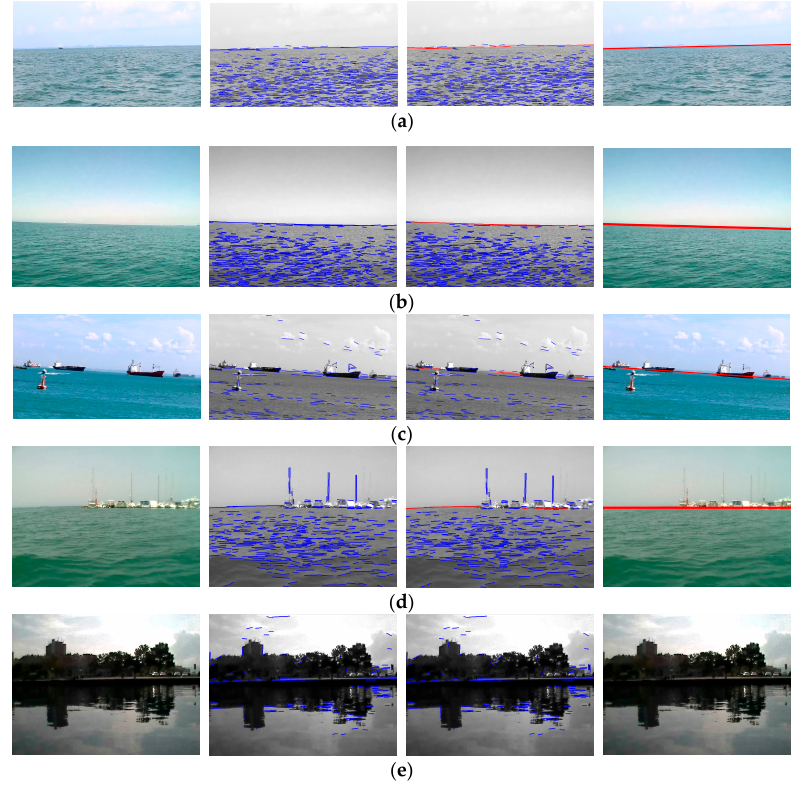
Figure 8. CFS detection results for the images from Singapore Maritime Dataset (SMD) and Marine Obstacle Detection Dataset (MODD) with different backgrounds. The first column is the original images and the next three columns are the output of the coarse detection, fine detection, and robust stitching of CFS, respectively: ( a ) Test results for a low clutter image ( clutter = 11) with the horizon line from SMD; ( b ) Test results for a low clutter image ( clutter = 11) with the horizon line from MODD; ( c ) Test results for a high clutter image ( clutter = 17) with the horizon line from SMD; ( d ) Test results for a high clutter image ( clutter = 17) with the horizon line from MODD; ( e ) Test results for a high clutter image ( clutter = 41) without the horizon line from